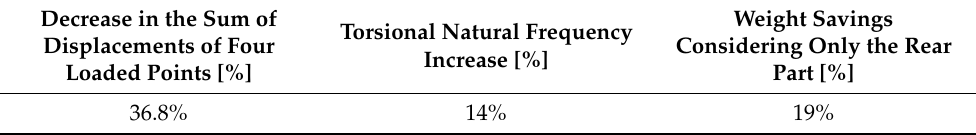
Table 1. Static and dynamic optimization.